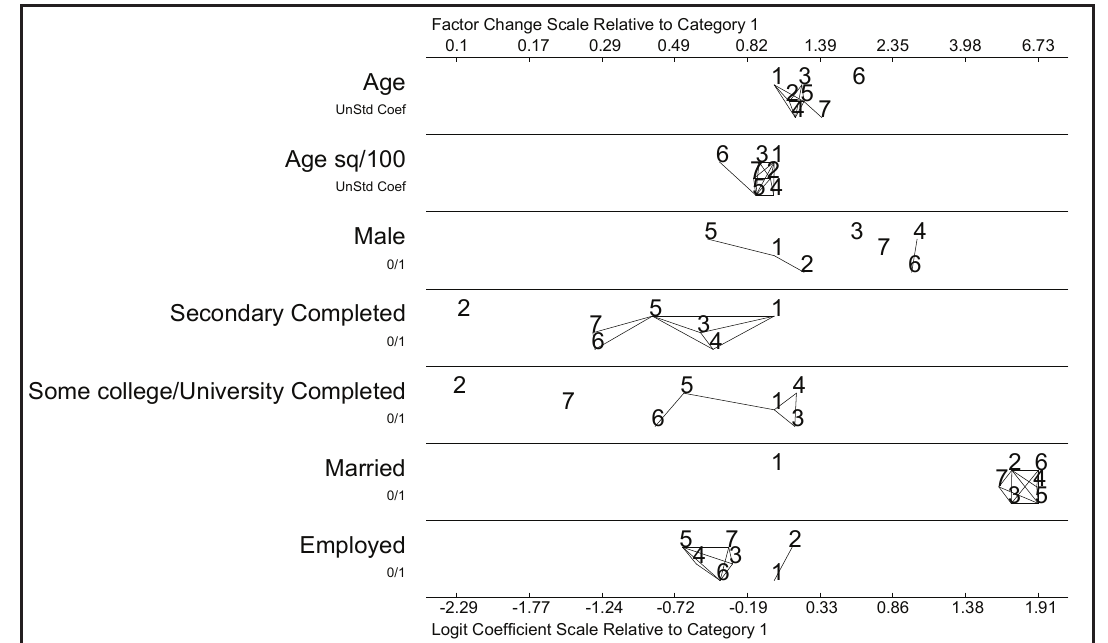
Factor Change Scale Relative to Category